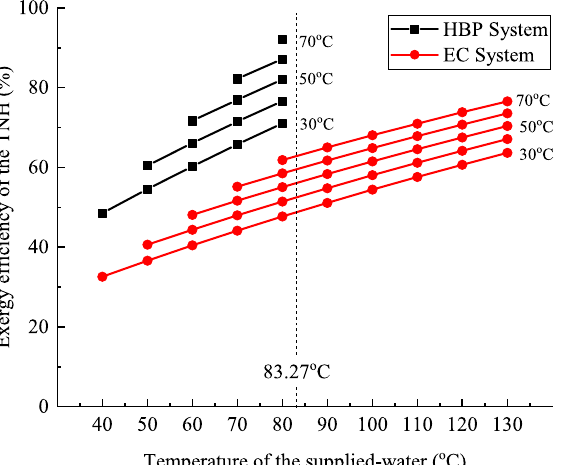
Figure 11. Influences of the returned- and supplied-water temperatures on η ex